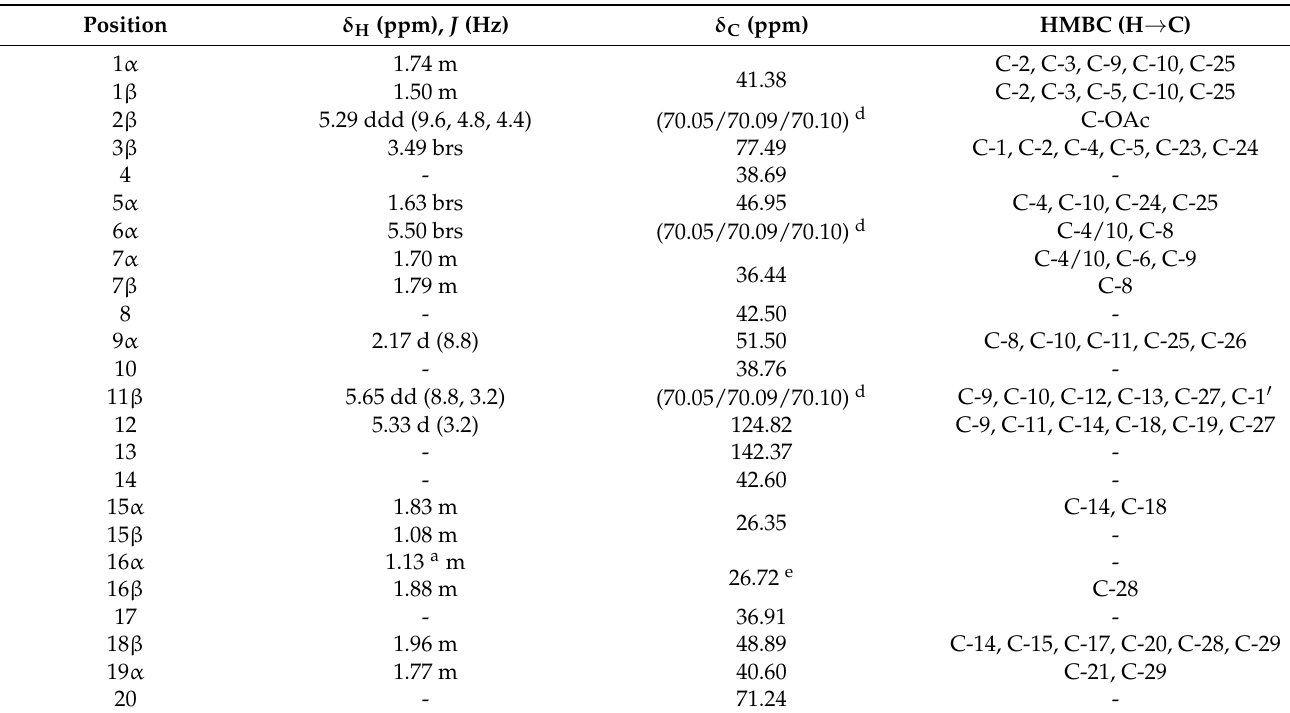
Table 1. 1 H NMR (400.17 MHz) and 13 C NMR (100.63 MHz) data of compound 1 in CDCl 3